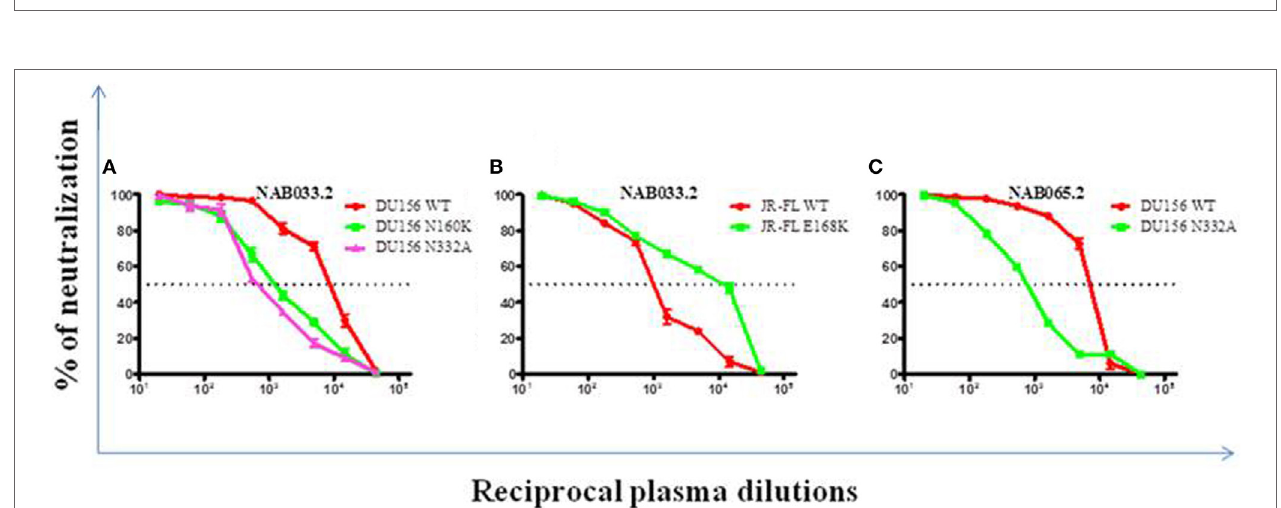
FigUre 6 | Neutralization analysis to identify glycan-dependent bNAbs. (a) Neutralization assay was performed against DU156WT, DU156N160K, and DU156N332A. (B) Presence of PG9/PG16 like bNAb specificity in sample NAB033 was confirmed by performing neutralization assay with JR-FL WT and JR-FL E168K. (c) Presence of PGT series like bNAbs in the sample NAB065 was confirmed by performing neutralization assay with DU156WT and DU156N332A. Each sample was tested in duplicate (1:20 to 1:43,740 dilutions), and the experiment was repeated on two independent occasions. ID 50 values were calculated using non-linear regression with variable loops using Graph pad prism 5.0.